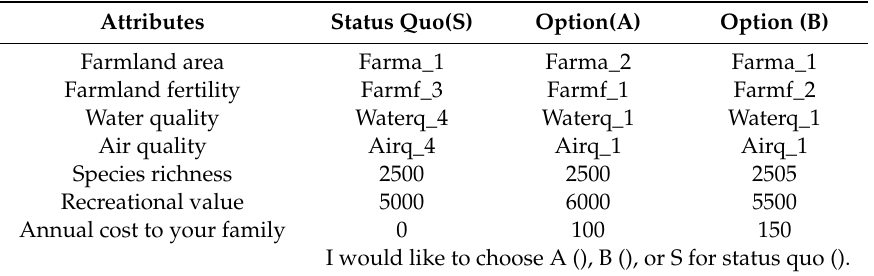
Table 2. An example ofa choice